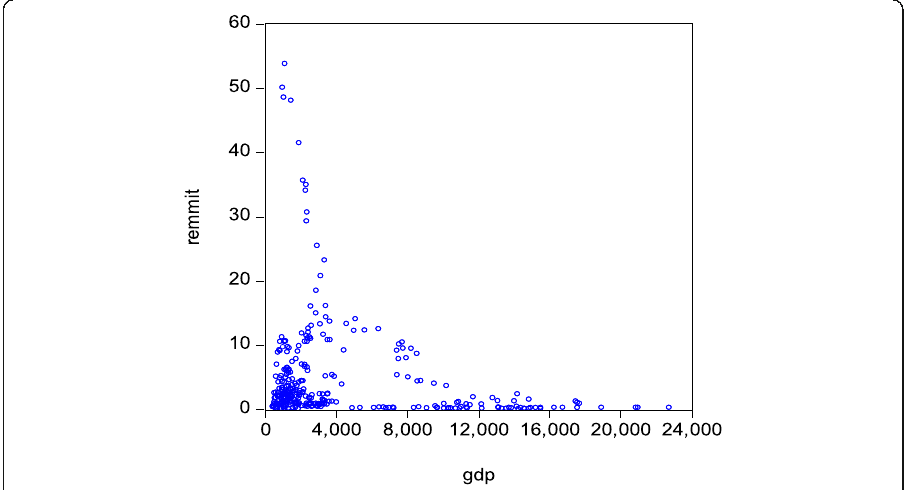
Fig. 1 The Scatter plot of remittance flow and GDP in the selected SSA